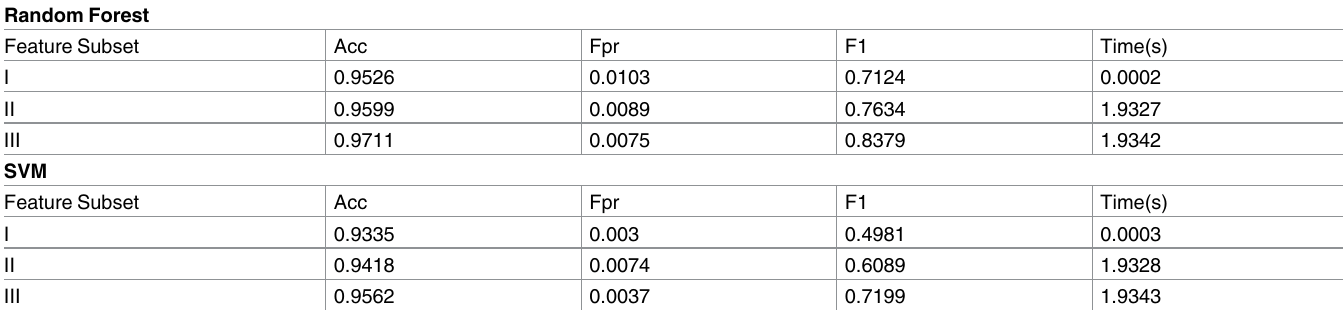
Table 8. Detection performance of different feature